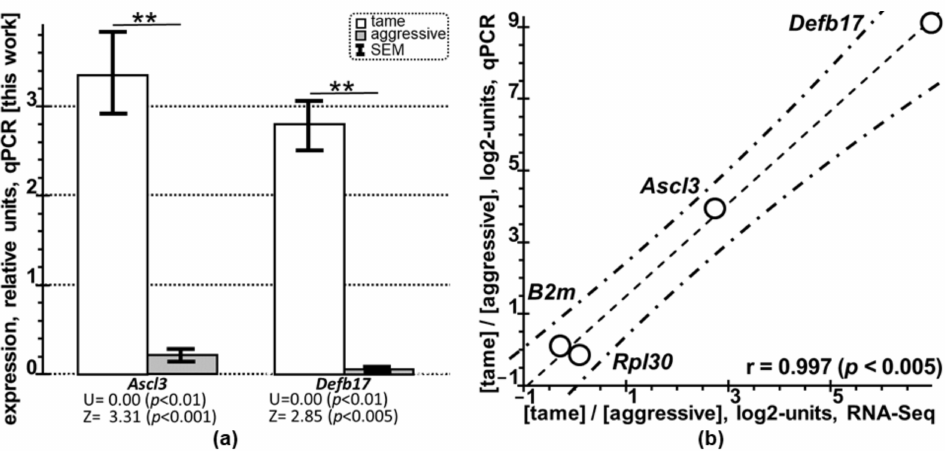
Figure 1. qPCR-based selective verification of the DEGs identified with RNA-Seq in the PAG of tame versus aggressive rats. Legend: ( a ) Both DEGs, Ascl3 and Defb17 , are significantly overexpressed in the PAG of the tame adult male rats (white bars) compared to their aggressive conspecifics (gray bars). Bar height: mean; error bars: standard error of the mean [SEM]; the double asterisk (i.e.,